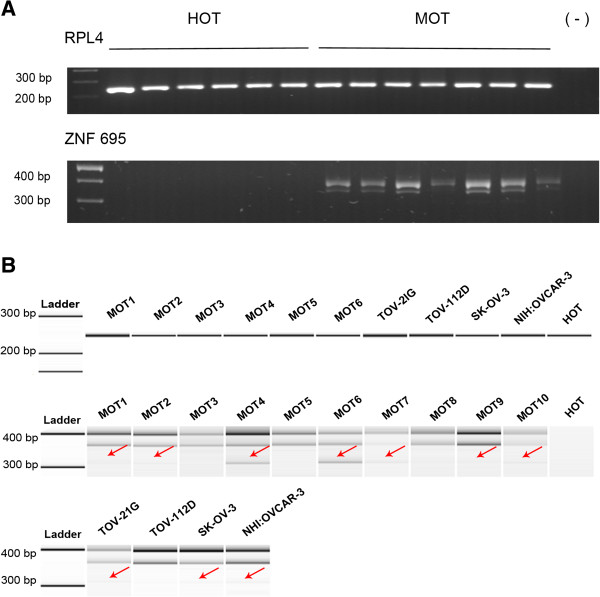
ZNF695 transcripts of healthy ovarian tissue, individual ovarian cancer samples, and cell lines. A) Agarose gel showing the raw RT-PCR products obtained from one HOT (n = 6) sample and MOT (n = 7) samples. Above, RPL4 protein (housekeeping), below, ZNF695. B) RT-PCR products run on a DNA Chip Agilent bioanalyzer. Top row: housekeeping gene RPL4. Middle and bottom rows: individual transcripts of each of the differentially spliced mRNAs in malignant ovarian cancer tissue (MOT, n = 10) and individual ovarian cancer cell lines (n = 4, shown by their names).